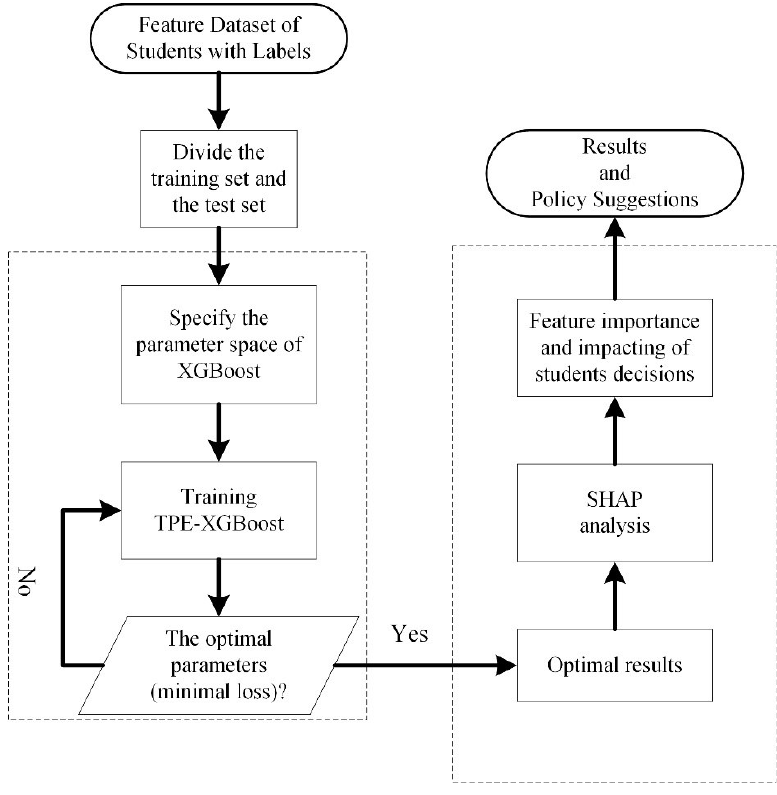
Figure 1. Research Framework.